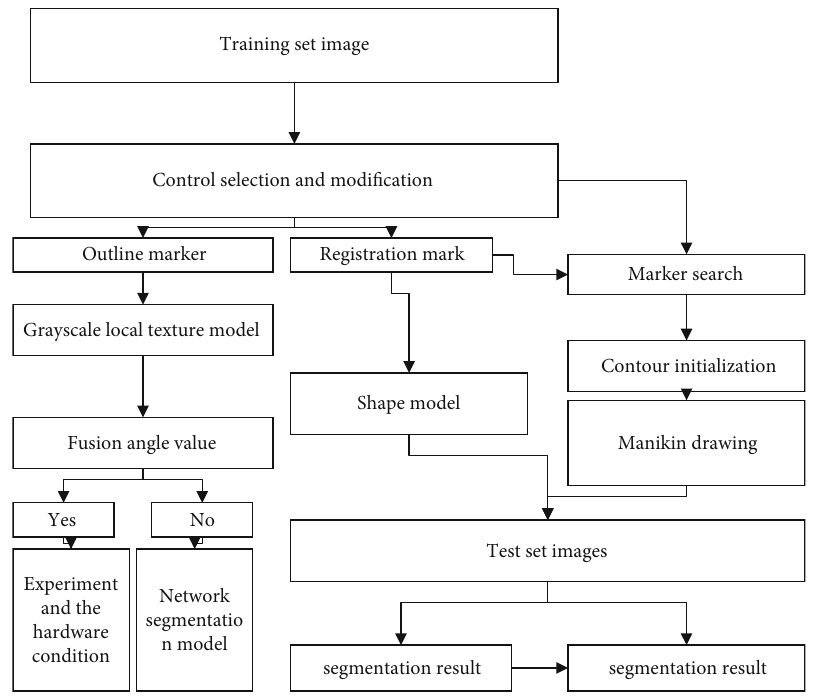
Figure 3: Flowchart of active shape model segmentation.